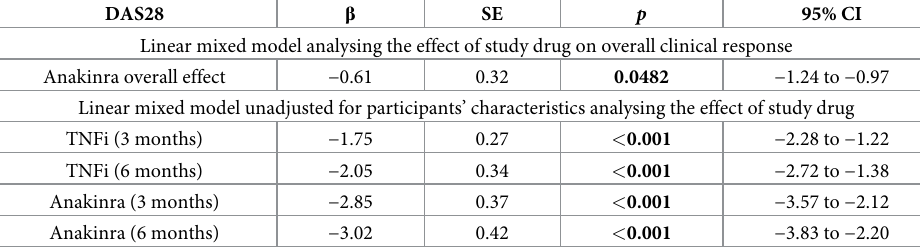
Table 4. Analysis of DAS28 as clinical response, linear mixed model analysing the effect of study drugs on DAS28.